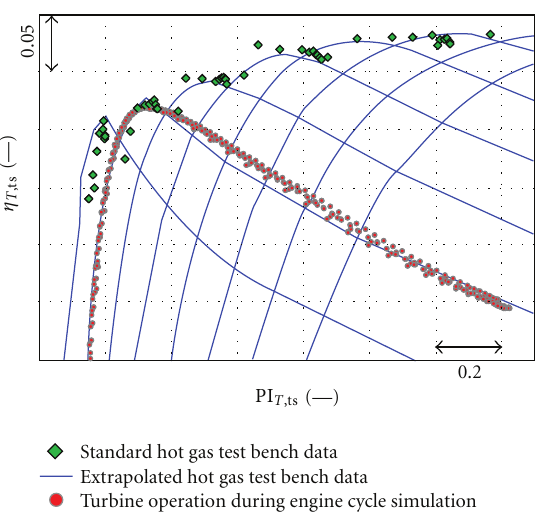
Figure 18: On-engine turbine